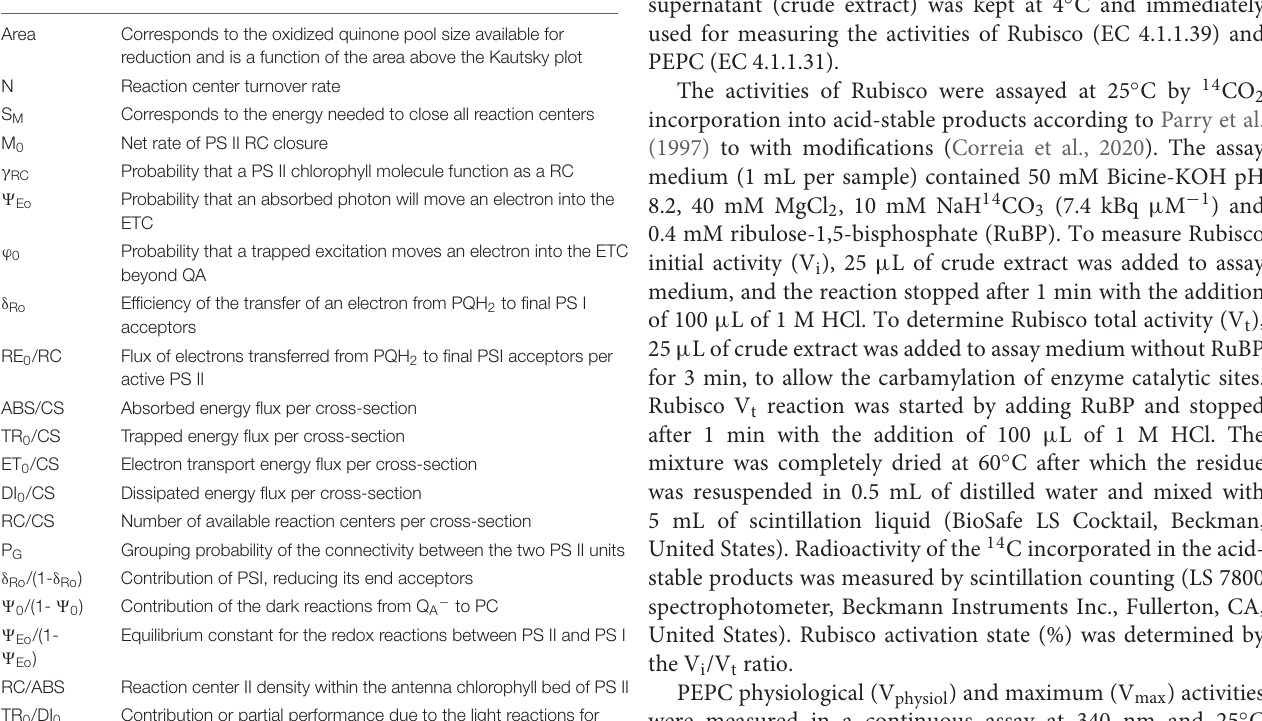
TABLE 1 | Fluorometric analysis parameters and their description. JIP-test